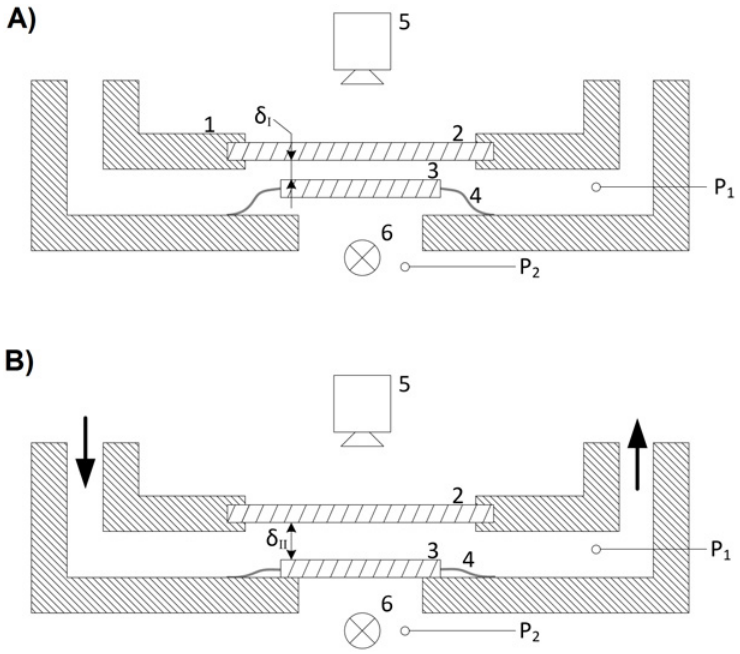
Fig 3. Schematic representation of the operating principle of the flow cell. A) P1 < P2, δ I < 5 μ m, ready for image acquisition. B) P1 > P2, δ II > 1.2 mm. 1: housing 2: cover slip 3: microscope slide 4: membrane 5: image acquisition 6: